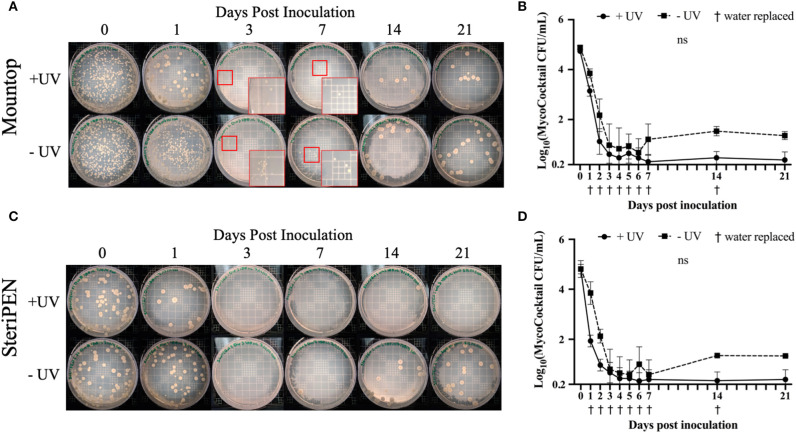
The simple action of water replacement reduces NTM counts. Mountop (A,B) and SteriPEN (C,D) systems were inoculated with MycoCocktail and allowed to incubate at room temperature overnight. After incubation, the MycoCocktail was UV-C disinfected as per the manufacturer's protocol (+UV) or not exposed to UV (–UV). The suspensions within each system were filtered, plated for CFU, and the suspension replaced with sterile tap H2O. CFU plating and water replacement was performed daily for 7 days and weekly up to 21 days post-inoculation. (A,C) Representative images of MycoCocktail CFU in Mountop and SteriPEN across 21 days of UV-disinfection. Smaller red boxes indicate regions where growth was difficult to visualize. Larger red boxes show colonies magnified ~6-fold. (B,D) Log(MycoCocktail CFU) across 21 days with and without UV treatment by Mountop or SteriPEN. n = 3 (+UV) or n = 2 (–UV) independent CFU measurements per timepoint. ns, not significant.